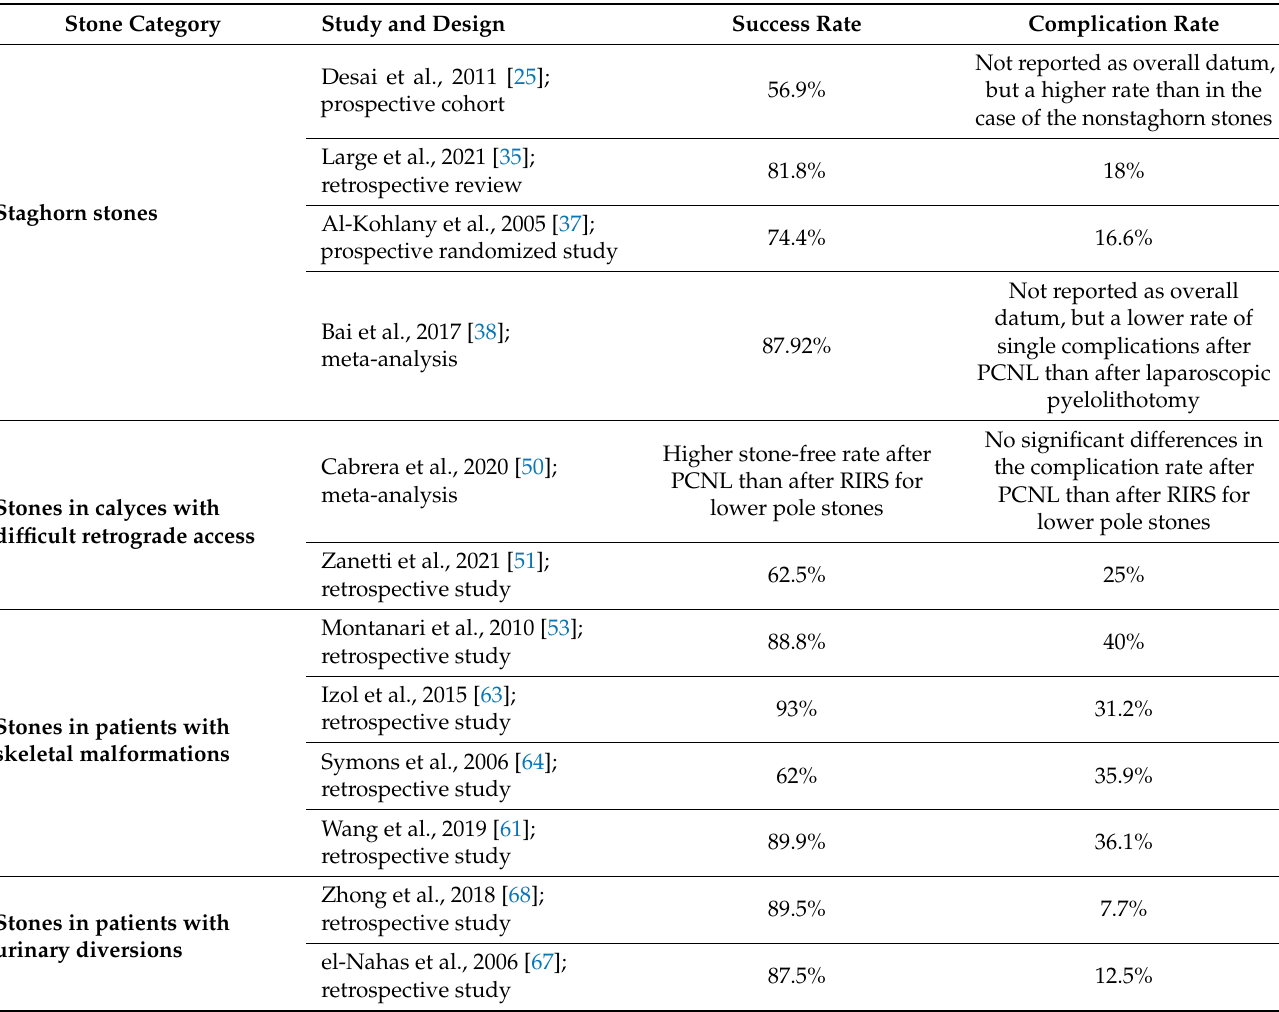
Table 1. Treatment results for specific categories of stones and patients as reported in the